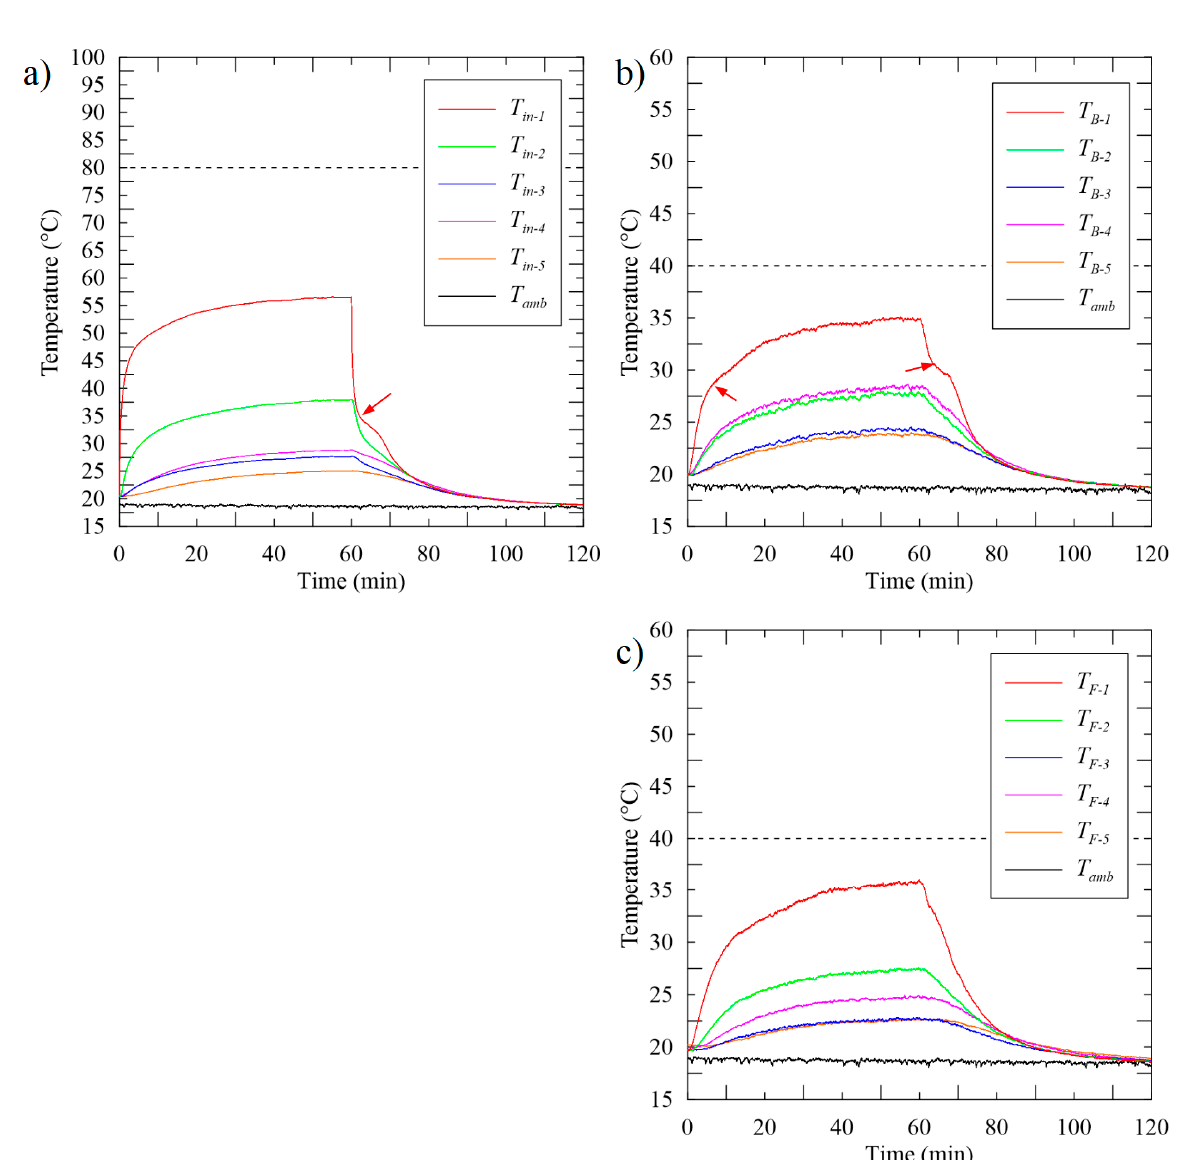
Figure 11. Temperature measurements on the ( a ) inside, ( b ) back cover, and ( c ) display of the mock tablet with LHTES, a heat spreader, TIM, and a heat generation rate of 4.5 W (the dashed line represents the relevant temperature limit). Arrows indicate inflection points (see text for discussion).